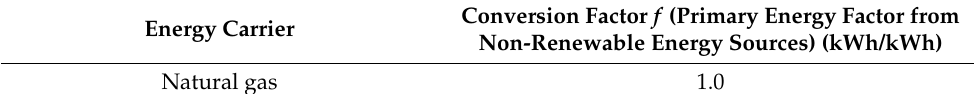
Table 12. Values of conversion factors.